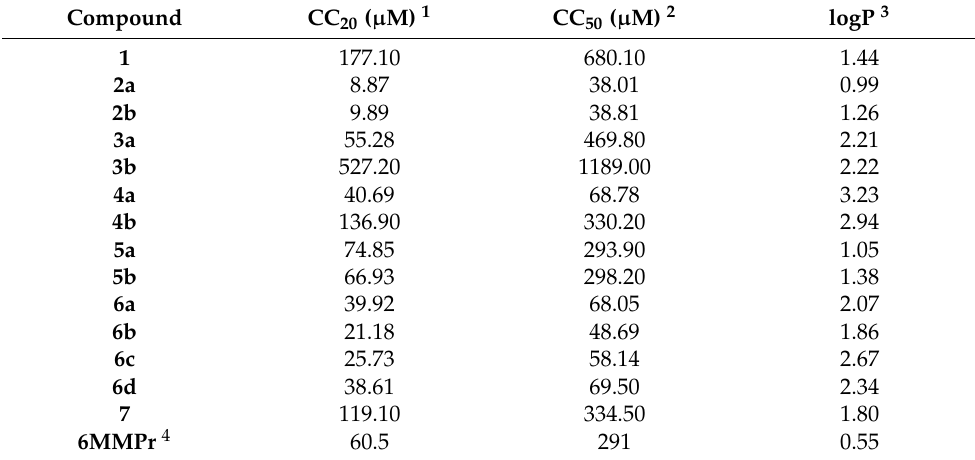
Table 2. Cytotoxicity assay in Vero cells (CC20 and